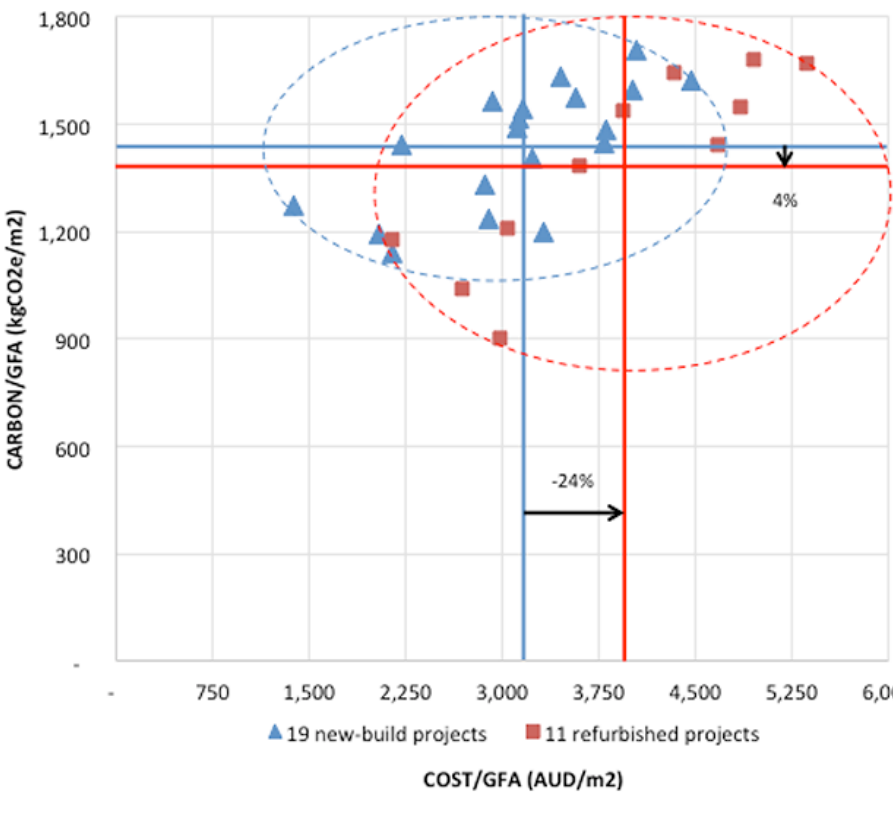
Figure 7 New-build versus Refurbished EC and Cost Comparison